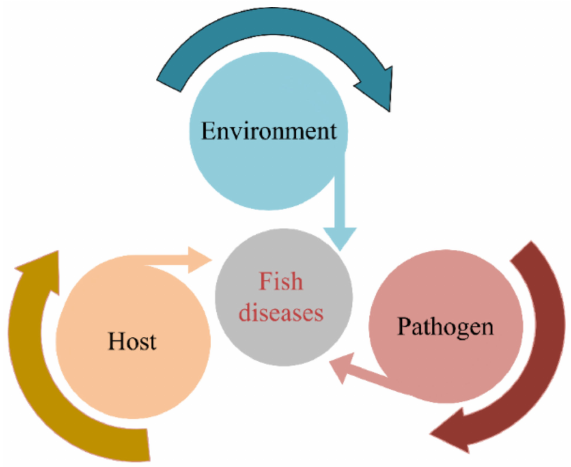
Figure 2. The interaction between host, pathogen, and